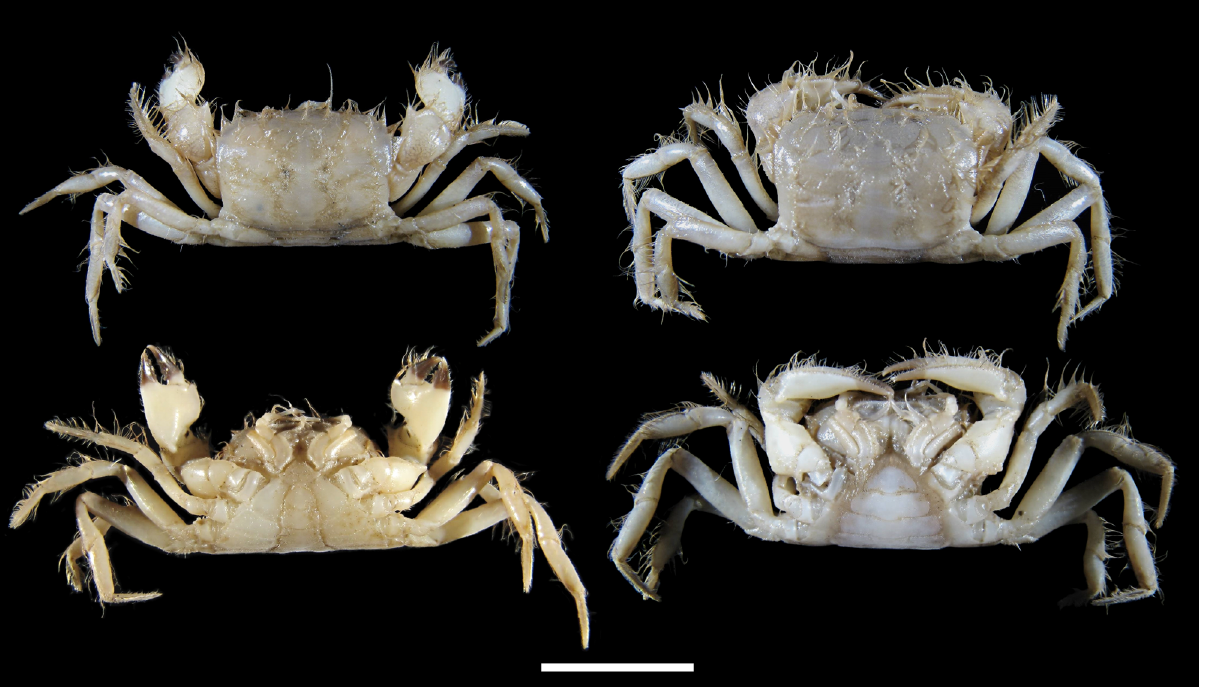
Figure 1. Malacoplax californiensis . Dorsal and ventral view of male (left) and female (right). Scale bar, 10